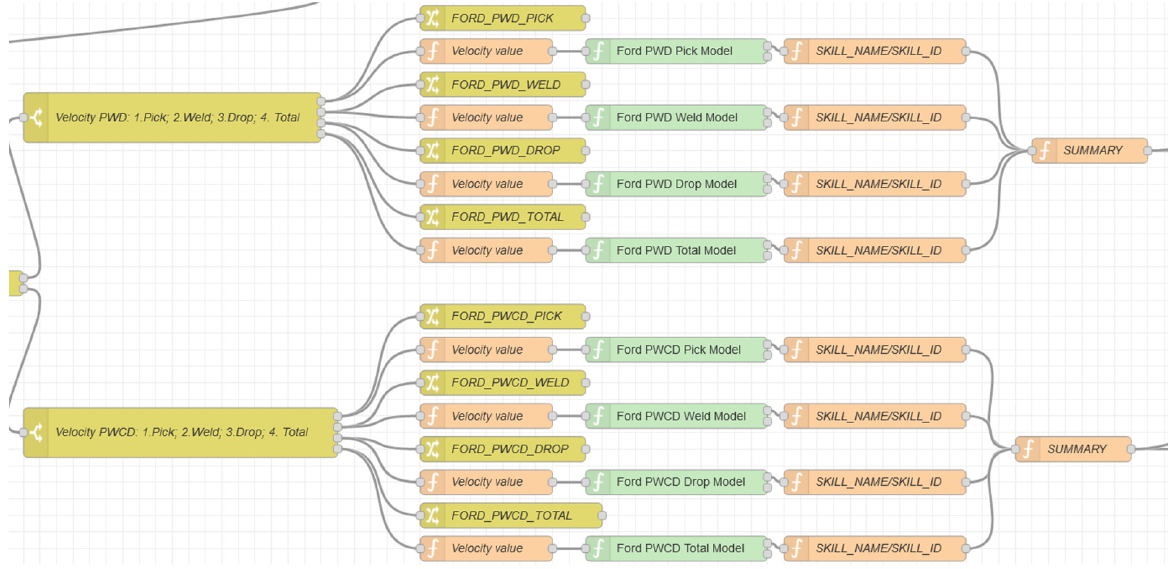
Figure 13. Switch nodes used for routing the messages using the Ford station as example. In the edit switch node, from left to right, we have: Stations: 1. Ford; 2. VW, Ford: 1. PWD; 2. PWCD and Velocity PWD: 1. Pick; 2. Weld; 3. Drop; 4. Total. The same logic was used for the VW station.